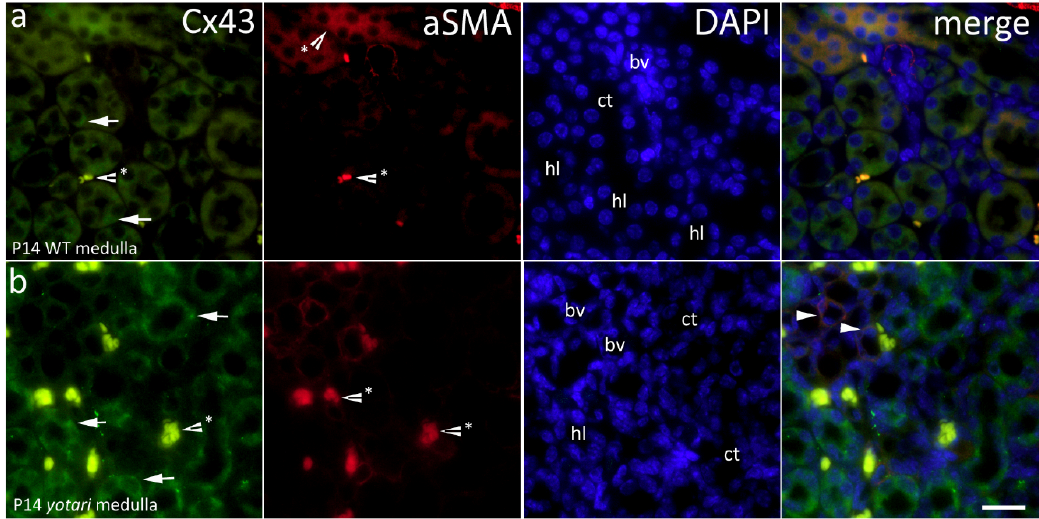
Figure 4. Immunofluorescence staining of postnatal yotari ( b ) and wild type ( a ) mouse kidneys with the Cx43 marker and co-expression of Cx43 and aSMA with DAPI nuclear staining. Expression of Cx43 (arrows), collecting tubules (ct), blood vessels (bv), loop of henle (hl) and distal convoluted tubules (dt). Co-expression of Cx43 and aSMA (arrowheads) can be seen on merged photographs. Autofluorescence of nephron tubules and erythrocytes (*), not to be mistaken with positive immunofluorescence staining. Scale bar is 20 μ m, refers to all images.